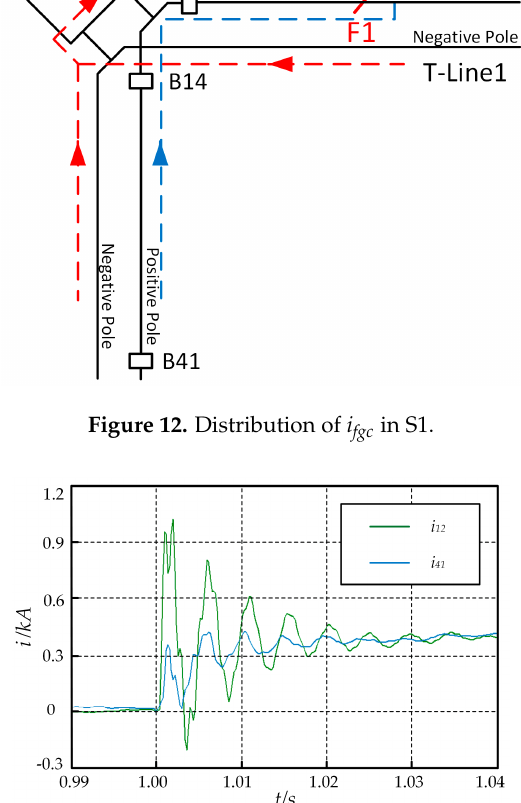
Figure 13. i 12 and i 41 when positive pole-to-ground fault.